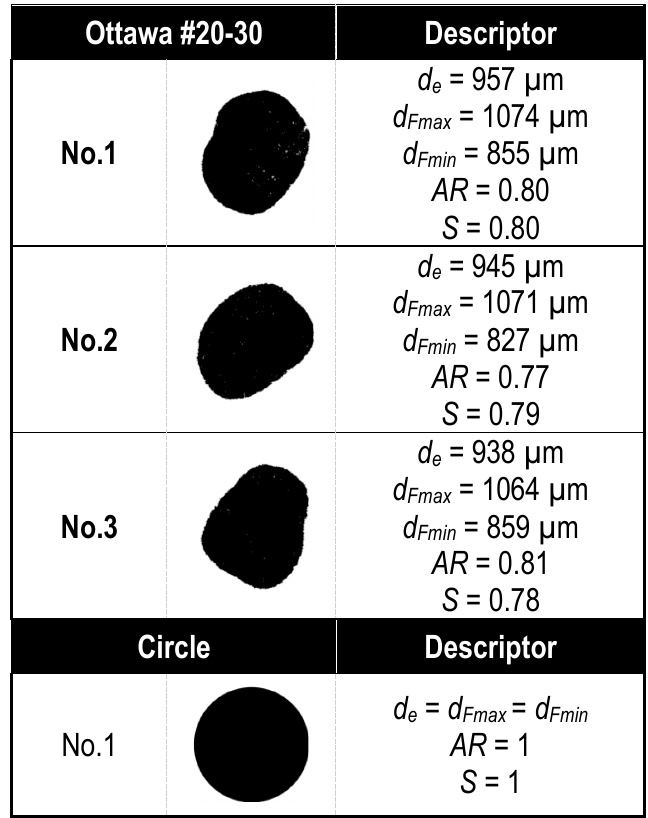
Figure 3. Images of Ottawa #20-30 sand particles captured using Dynamic Image Analysis ( Top ) compared to synthetic circular particle ( bottom ).